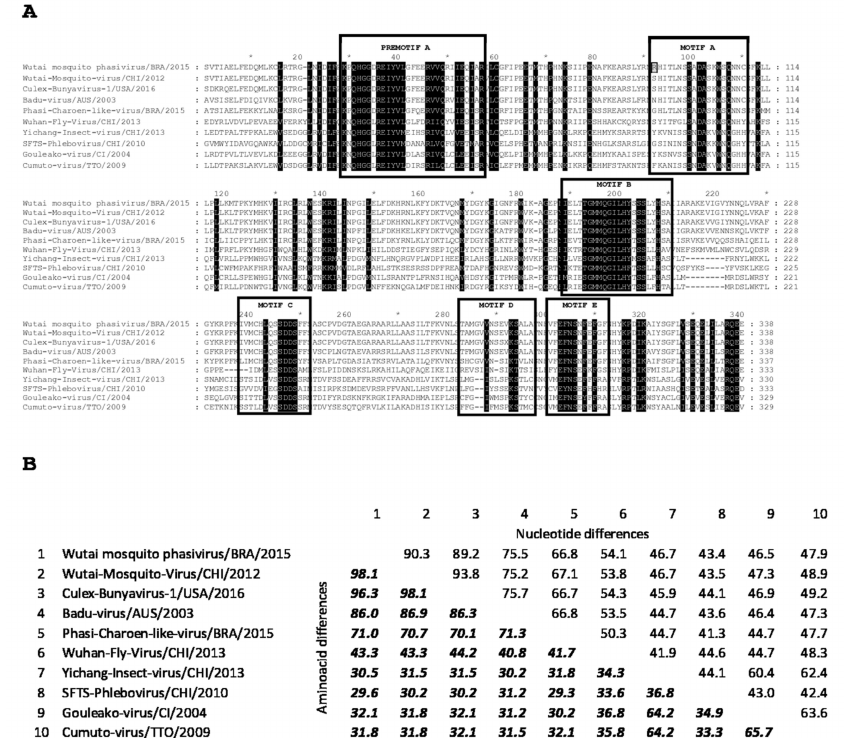
Figure 1. Sequence alignment of RdRp third conserved motif of selected viruses. ( A ) Amino acid alignment showing pre-motif A and motifs A, B, C, D, and E, highlighted by boxes. Highly conserved aminoacidresiduesbetweenWutai-Mosquito-Phasivirus / BRA / 2015andselectedbunyavirusesaremarked in black. The only difference found within the motifs between Wutai-Mosquito-Phasivirus / BRA / 2015 and the species prototype strain Wutai-Mosquito-Virus / CHI / 2012, in position 92 of the alignment is highlighted. Sequence alignment position is indicated in an upper marker line, every 10 residues. Number 1 in the alignment corresponds to amino acid position 1001 of the Wutai-Mosquito-Phasivirus / BRA / 2015 and Badu-Virus / AUS / 2003; 949 of Wutai-Mosquito-Virus / CHI / and Culex-Bunyavirus-1 / USA / 2016; 1002 of Phasi-Charoen-like-Virus / BRA / 2015; 970 of Wuhan-Fly-Virus / CHI / 2013; 909 of Yichang-Insect-Virus / CHI / 2013; 885 of SFTS-Phlebovirus / CHI / 2010; 880 of Gouleako-Virus / CI / 2004; and 895 of Cumuto-Virus / TTO / 2009. Numbers at the end of each line indicates the total number of amino acids in the corresponding row. ( B ) Pairwise comparison of percentage of differences per site, calculated at the nucleotide (upper right) and amino acid (lower left) levels between the Wutai-Mosquito-Phasivirus / BRA / 2015 and the selected bunyaviruses are shown. All the positions containing gaps and missing data were eliminated. There were a total of 966 nucleotide and 321 amino acid positions in the final